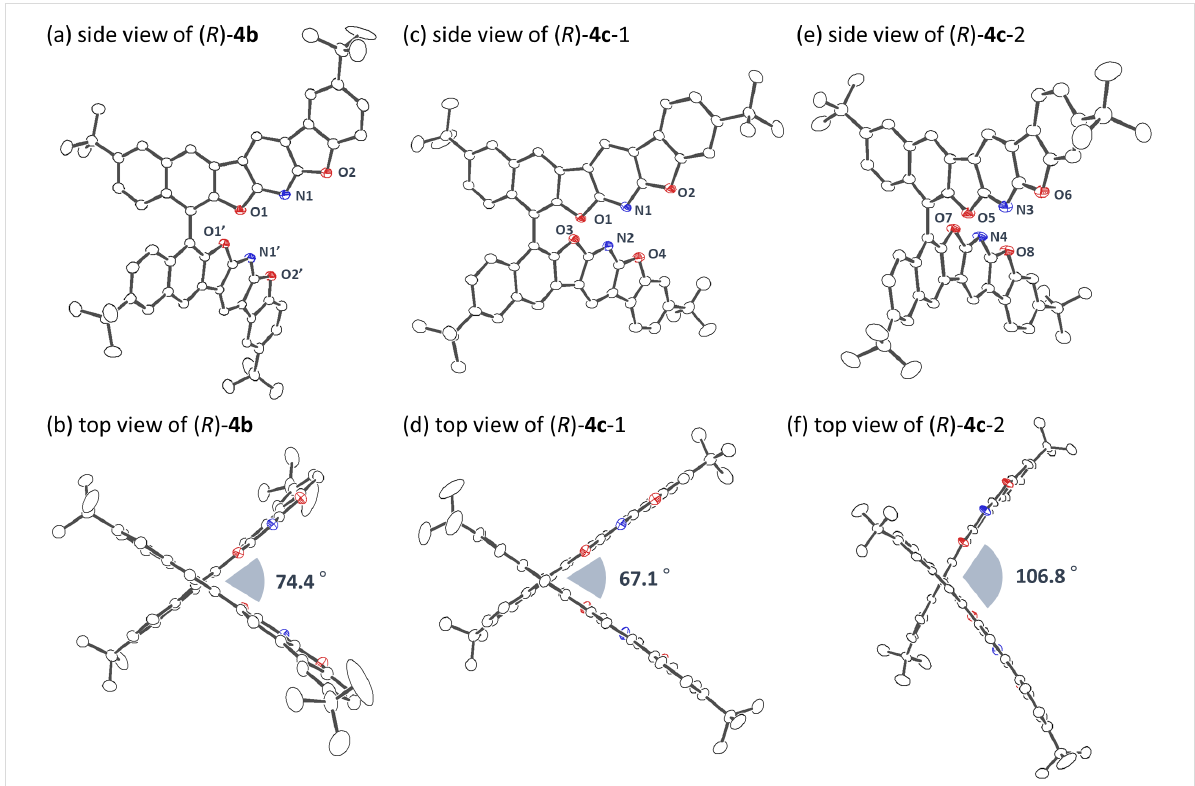
Figure 4: ORTEP drawings of 4b and 4c with 50% thermal probability. Hydrogen atoms and solvent molecules are omitted for clarity. Only major ori- entation of the disordered structure is displayed. The CCDC numbers are 1971471 for ( R )- 4b and 1971470 for ( R )- 4c .